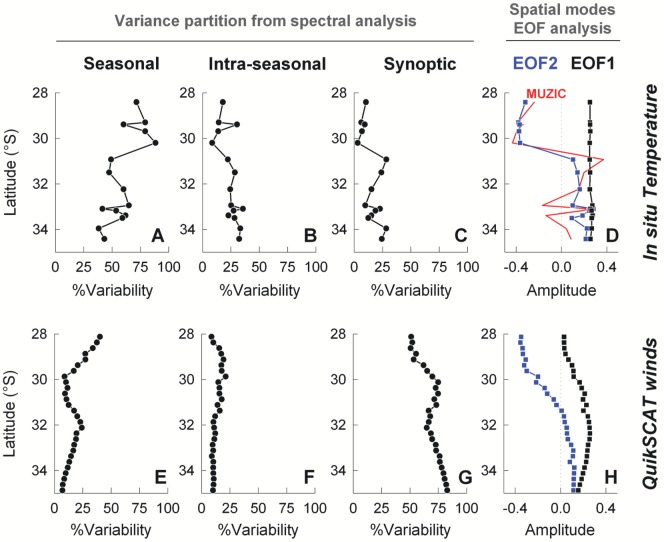
Latitudinal patterns in the variability of in situ temperature (A-E) and QuikSCAT alongshore wind (F-J).Panels on the left (A, F) show latitudinal long-term means for each variable. Panels on the mid three columns show percentages of total variability derived from spectral analyses that correspond to annual (B, G), intraseasonal (C, H), and synoptic (D, I) fluctuations. Panels on the far right (E, J) show the latitudinal distribution of the first 2 modes of EOF analyses. Red line in (E) corresponds to latitudinal distribution of the MUZIC index of upwelling-induced variability [30].